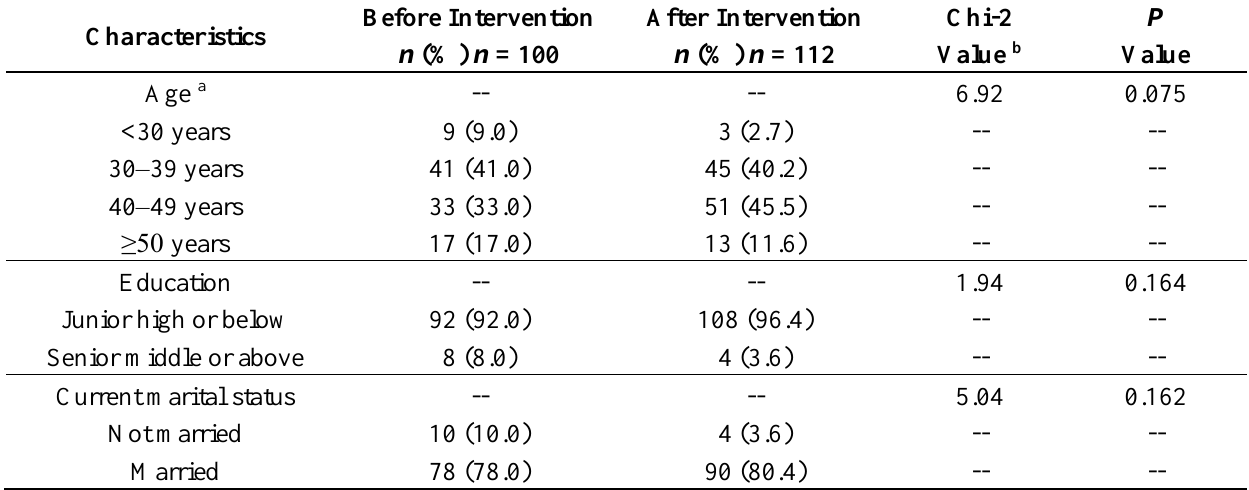
Table 1. Demographic and social characteristics of street-based sex workers in Chongqing, Southwest of China,